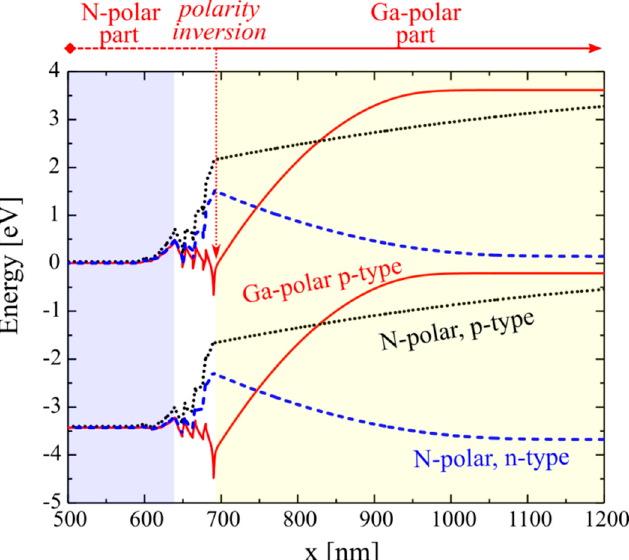
Figure 12. Conduction and valence band profiles for three different nanowire structures, as a function of the location in the wire. The growth direction goes from left to right. The dotted black line denotes the profile for a lightly doped N-polar structure, with a 2 × 10 15 atoms/cm 3 Mg concentration. The dashed blue line denotes the profile for the case in which oxygen compensated p-type doping, resulting in n-type doping. The red profile corresponds to the structure in which polarity inversion took place right at the beginning of the p-type layers. The dotted arrow indicates the position where polarity inversion took place for the wire presented in red. From that moment, the structure was Ga-polar, with a 5 × 10 16 atoms/cm 3 Mg concentration. The vertical axis shows the electron energy E = − e Ф , where Ф is the potential.